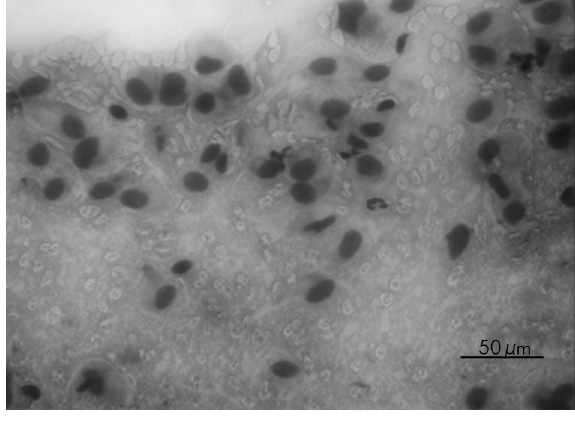
Figure 4. Presence of multinucleated atypical cells on the smears, with a sugestive report of mesenchimal malignat neoplasia (Panoptic stain).